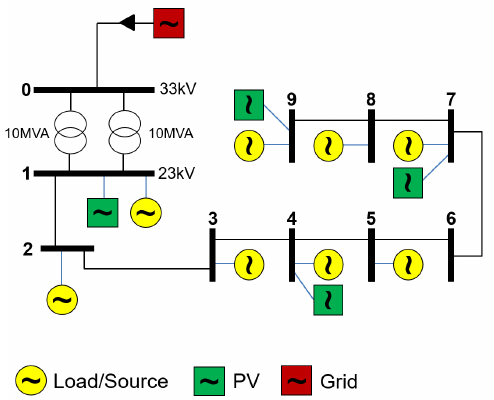
Figure 3. Electric diagram of the 10-bus MV radial distribution system.